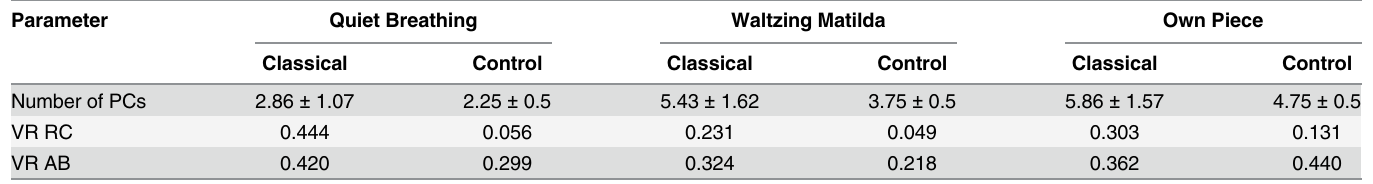
Table 2. Number of Principal Components (PC, mean ± SD) and Variance Ratio (VR) of PCA representations of RC and AB volume signals for clas- sical singers and untrained (control) individuals.